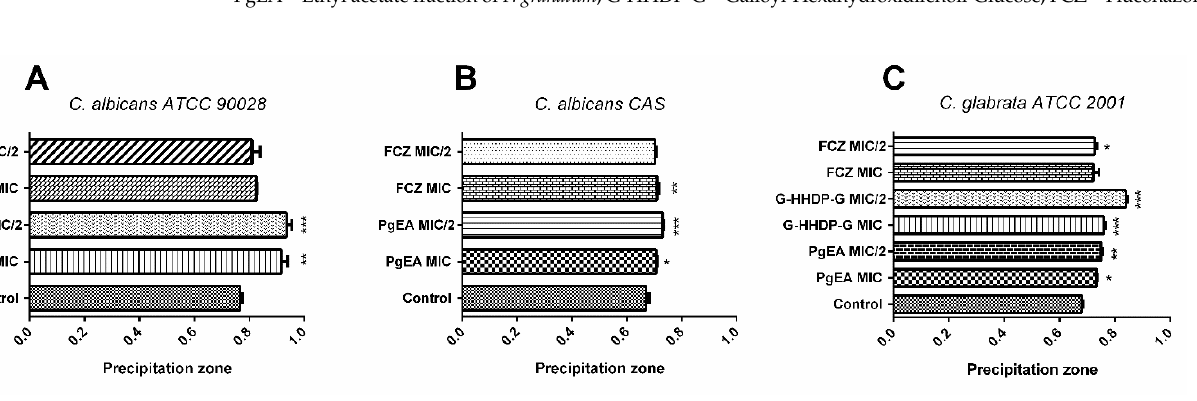
The precipitation zone represents the ratio of the diameter of the colony to the cloudy zone and colony diameter. VL: very low (Pz = 0.90 to 0.99); L: low (Pz = 0.80 to 0.89); H: high (Pz = 0.70 to 0.79); VH: very high (Pz ≤ 0.69).